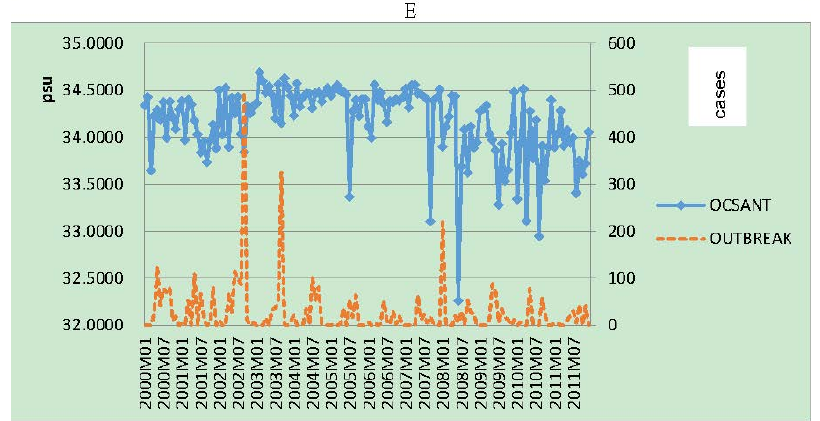
Figure 1. Dashed red line: Monthly incidence of Vibrio parahaemolyticus outbreaks in Taiwan from January 2000 to December 2011 compared to climatic variables for the same period: ( A ) average temperature (AVGTEMP); ( B ) Maximum daily rainfall (MAXRFD); ( C ) average relative humidity (AVGRH); ( D ) average ocean temperature (OCTEMP); ( E ) average ocean salinity (OCSANT).